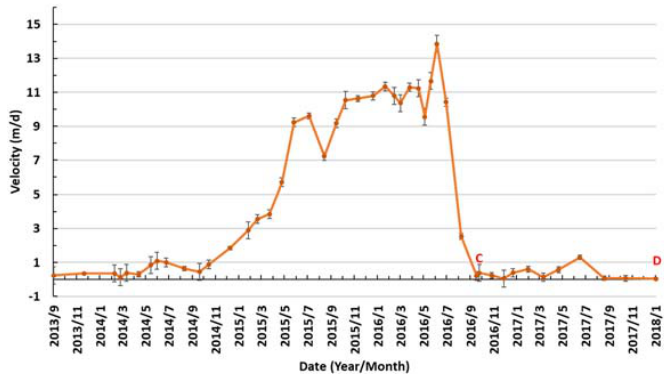
Figure 5. Temporal changes in the glacial surface velocity along the red line, as shown in Figure 4. The error bars indicate the uncertainty in the velocity measurements.